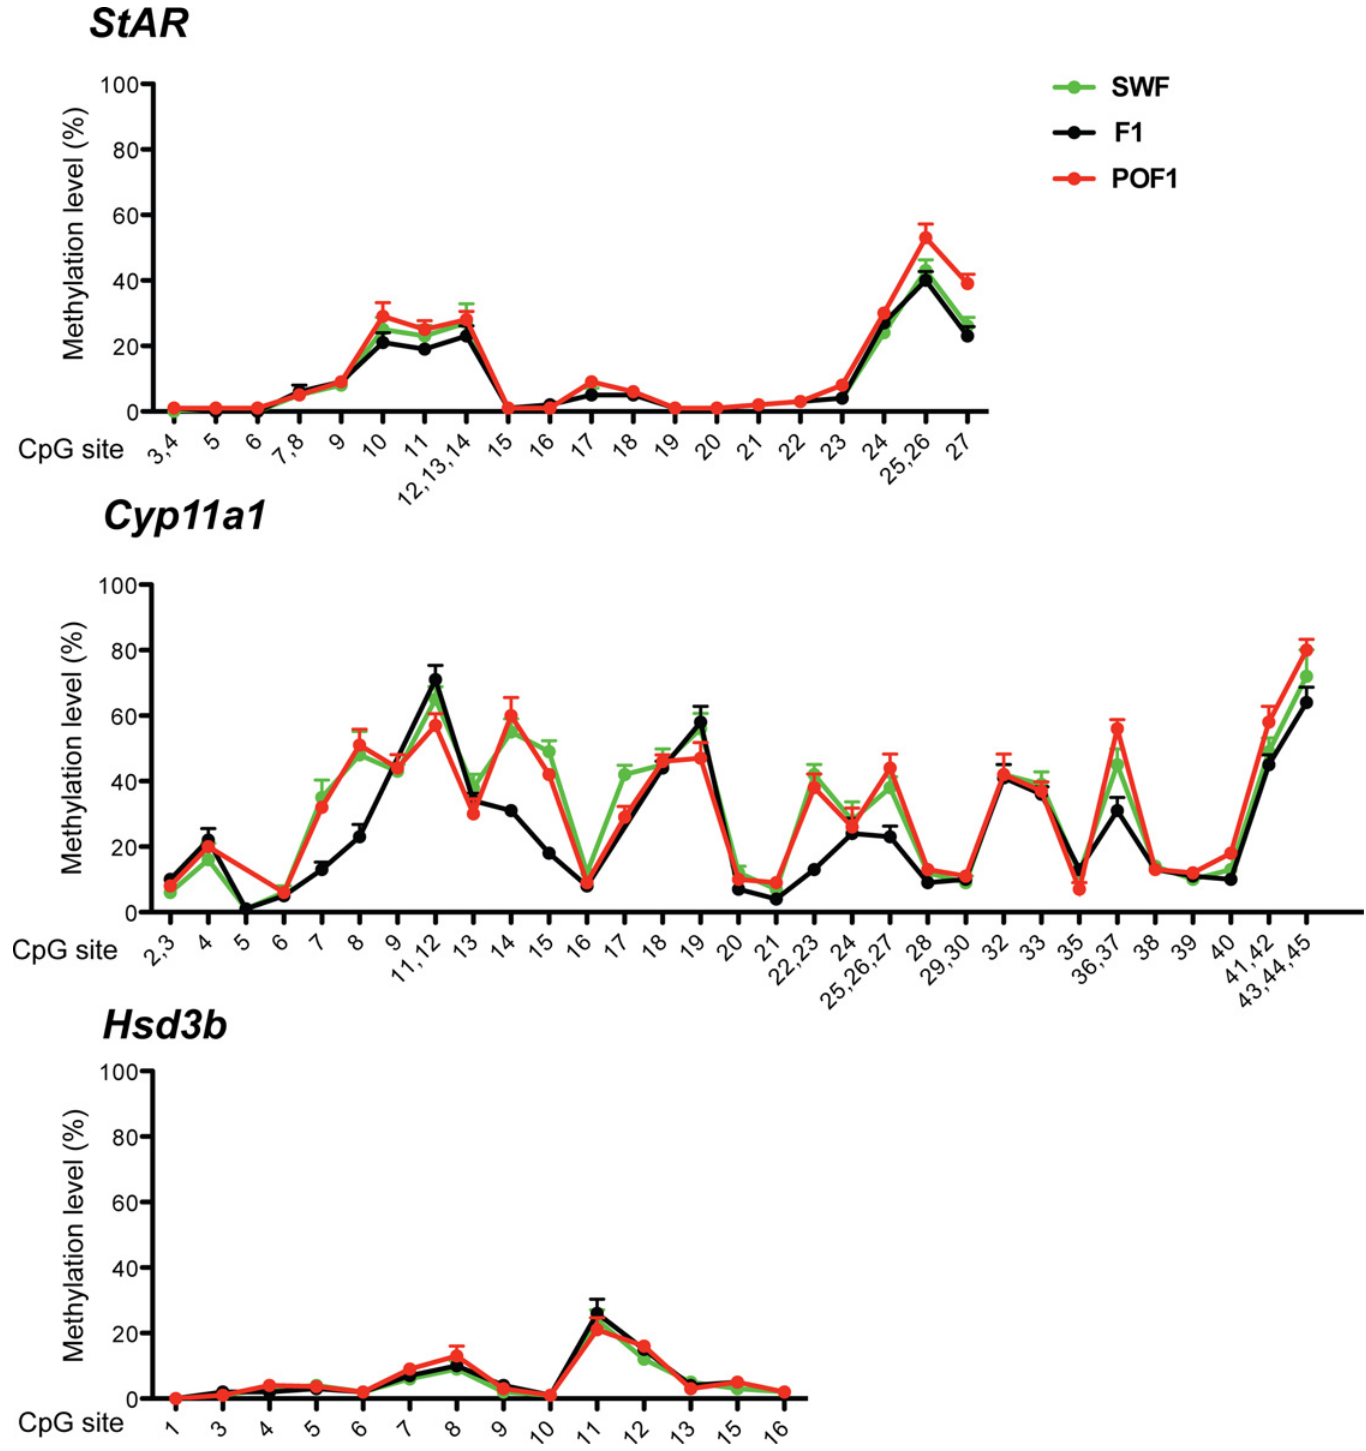
Fig 1. Methylation patterns of the Star, Cyp11a1 and Hsd3b promoters in chicken follicles. Site-specific methylation levels of the proximal promoters of Star, Cyp11a1 and Hsd3b from SWF, F1 and POF1 follicles were compared. The Sequenom MassARRAY platform was used for the quantitative methylation analysis. The CpG units locations are as defined in S1 Fig. Data are expressed as mean ± SEM. n = 3 animals.